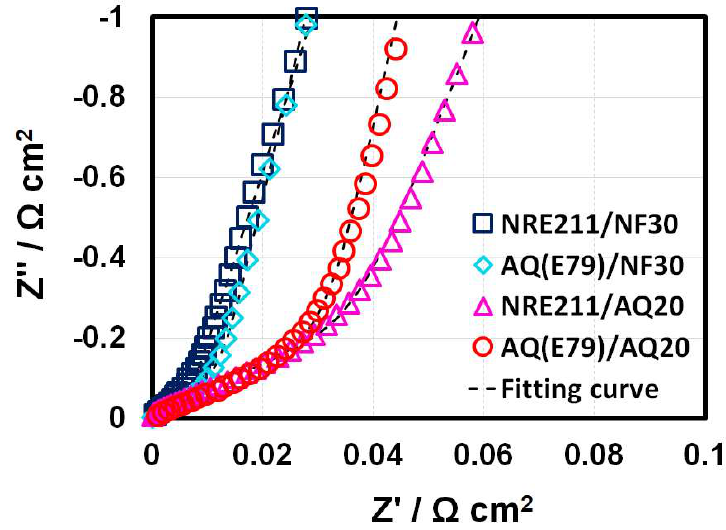
Figure 2. Nyquist plots of cathode CLs in the four MEAs under 80 ◦ C and 100% RH.